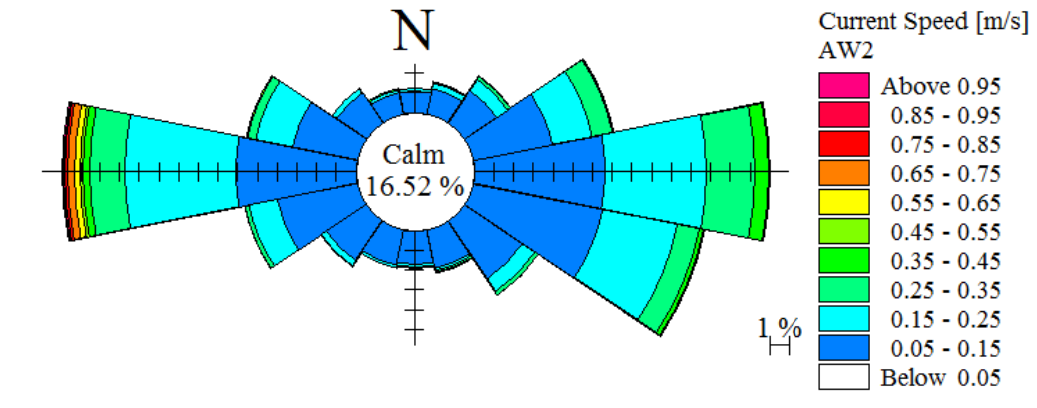
Figure4. AW2 data current